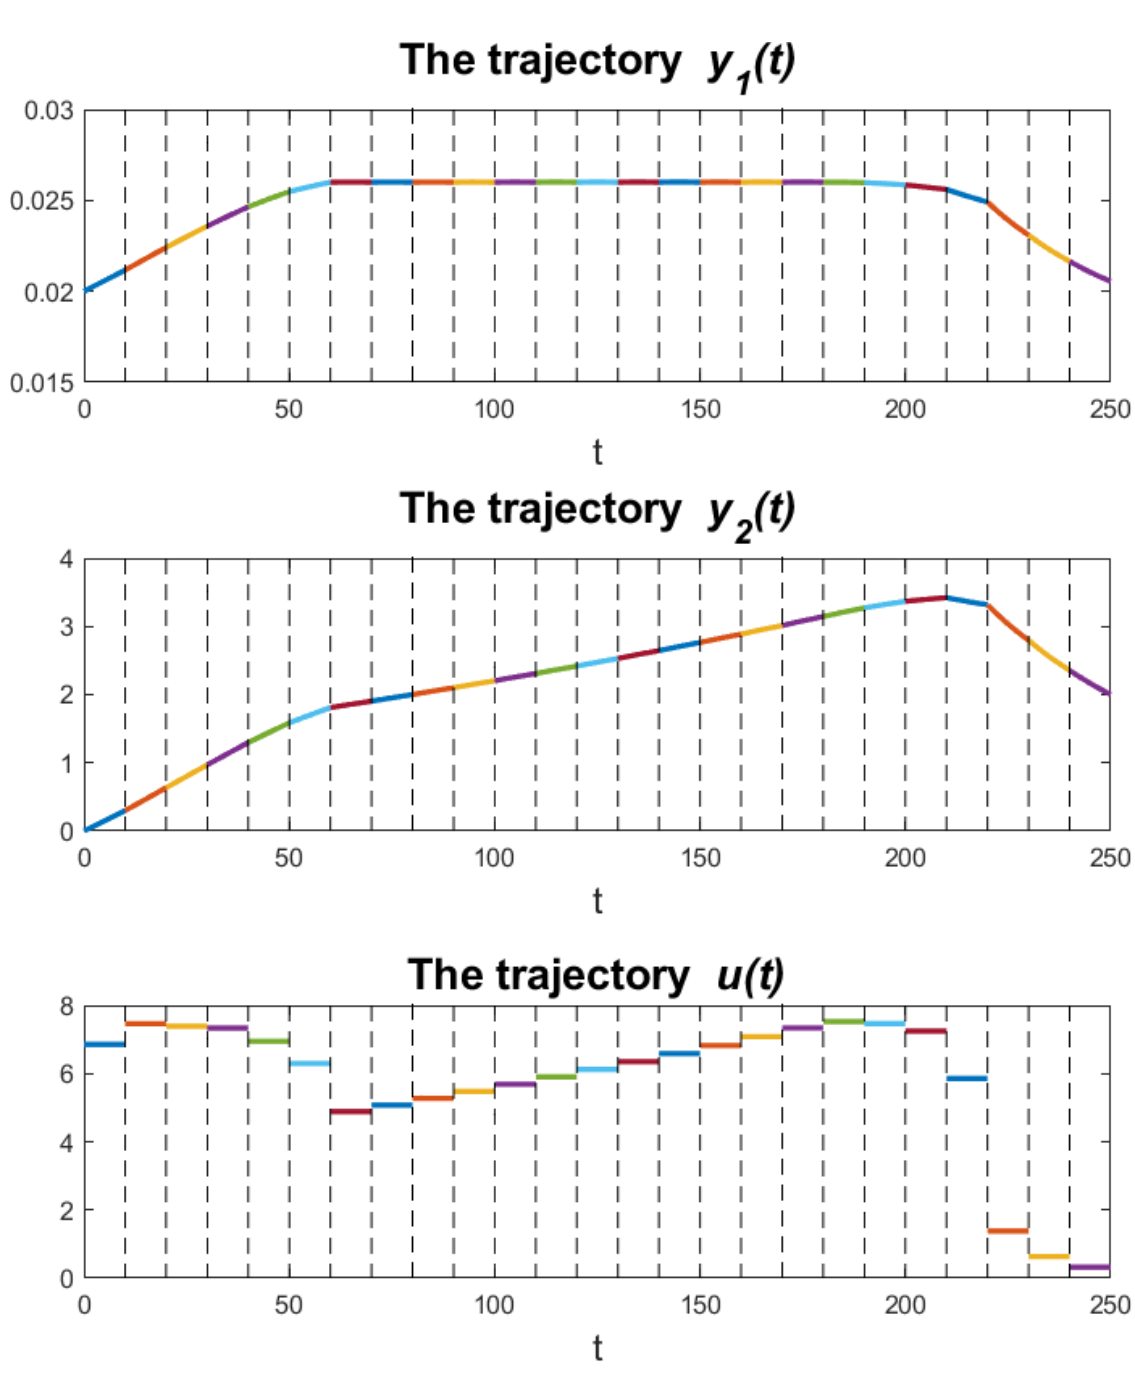
Figure 4. The obtained final solution—the state trajectories and control